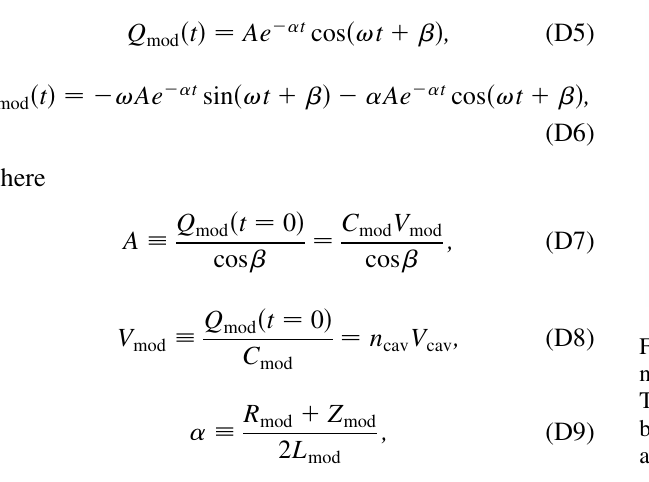
(cid:6) 1 = 2 calculated = (cid:5) L =C mod ; opt mod mod (cid:6) 1 = 2 . = (cid:5) L =C mod mod mod